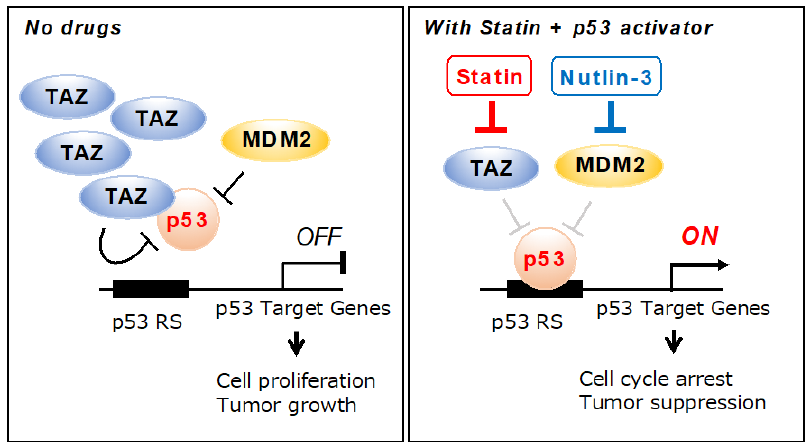
Figure 6. Schematic representation of a mechanistic model for TAZ-mediated activation of p53 by statin. The statin facilitated p53 transcriptional activity by repressing TAZ expression. Statins that decrease the p53-TAZ interaction in tumor cells that overexpress TAZ proteins may increase the cellular sensitivity to chemotherapeutic agents, such as p53 activators, inducing a stronger p53 response and suppressing tumor cell survival.